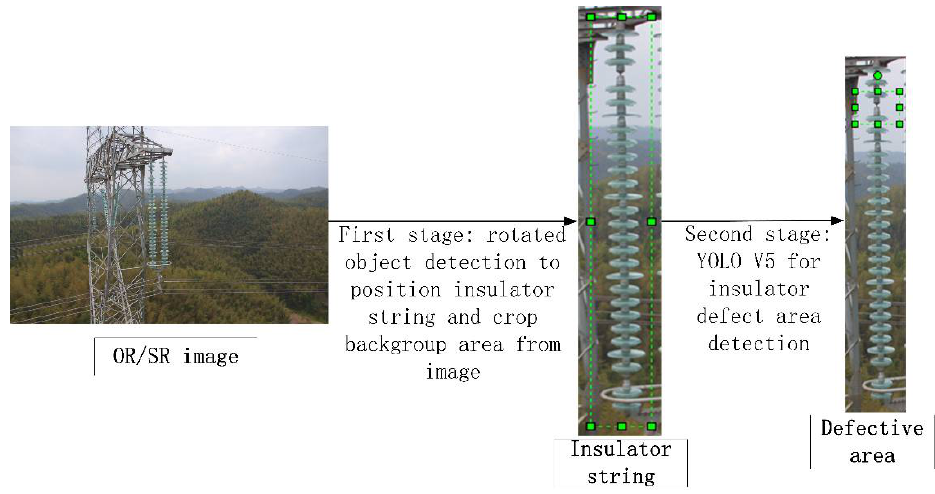
Figure 8. Two-stage cascading architecture for insulator defect detection.